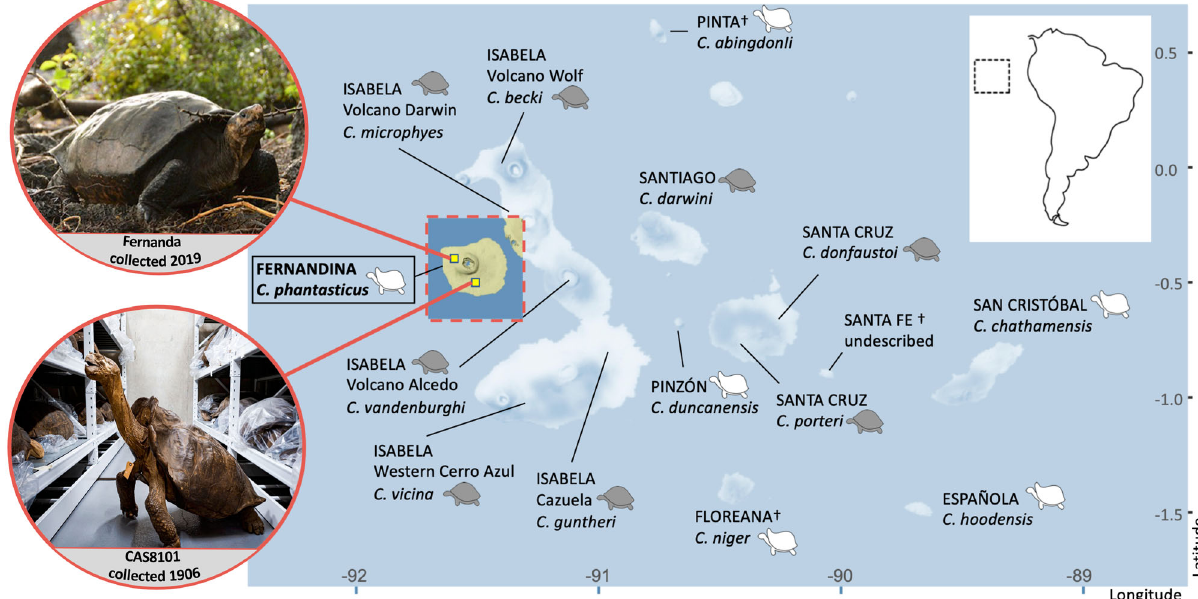
Fig. 1 Map of the Galapagos Archipelago, indicating the approximate locations on Fernandina Island where the Chelonoidis phantasticus individuals were found in 1906 and 2019. Island names are in capital letters, species names are in italics. Tortoise icons indicate the morphology of the species, either domed (gray), saddleback (white), or semi-saddleback (indicated with both icons present). Map tiles by Stamen Design, under CC BY 3.0. Data by OpenStreetMap, under ODbL. Image of Fernanda by Lucas Bustamante © Galapagos Conservancy, image of the historical specimen Kathryn Whitney © California Academy of